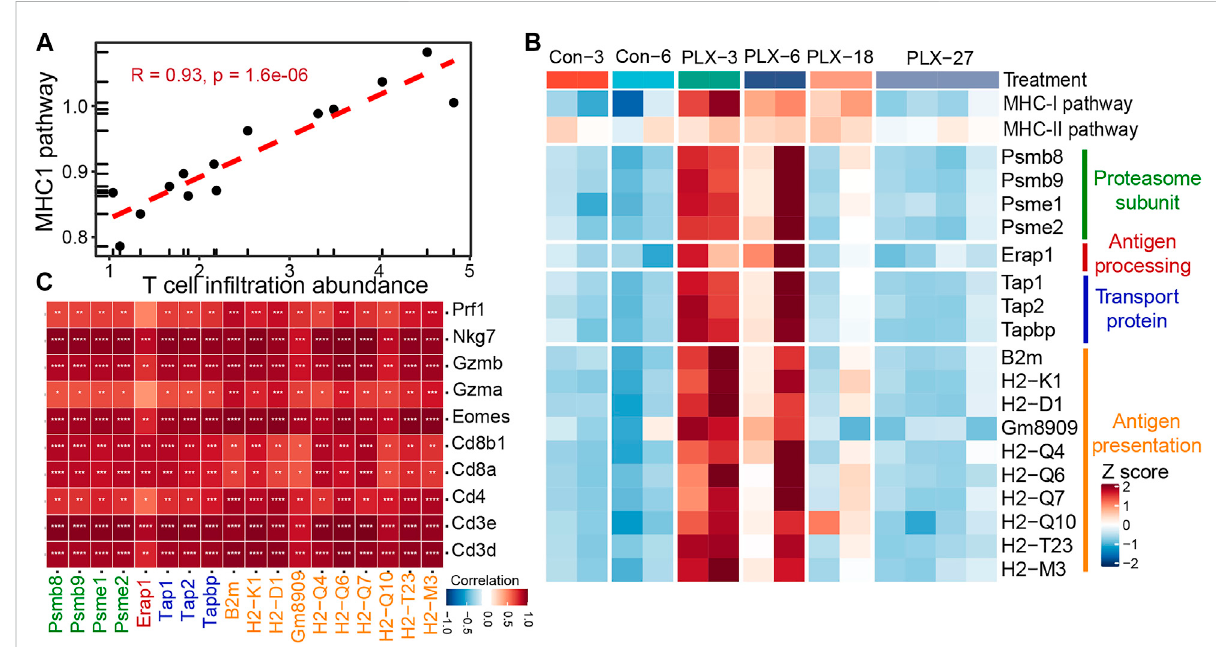
FIGURE 5 Correlation between MHC-I molecules and T cell in fi ltration in the mouse melanoma models. (A) Scatterplot showing Pearson ’ s correlation betweenMHC-IantigenprocessingandpresentationpathwaysandabundanceofTcellin fi ltrationinthemousemelanomamodels(GSE161430). (B) Heatmap showing the expression changes of MHC-I molecules at different times of BRAFi treatment in the mouse melanoma models. (C) Pearson ’ s correlations between MHC-I molecules and T cell marker genes were calculated based on the transcriptome data of the mouse